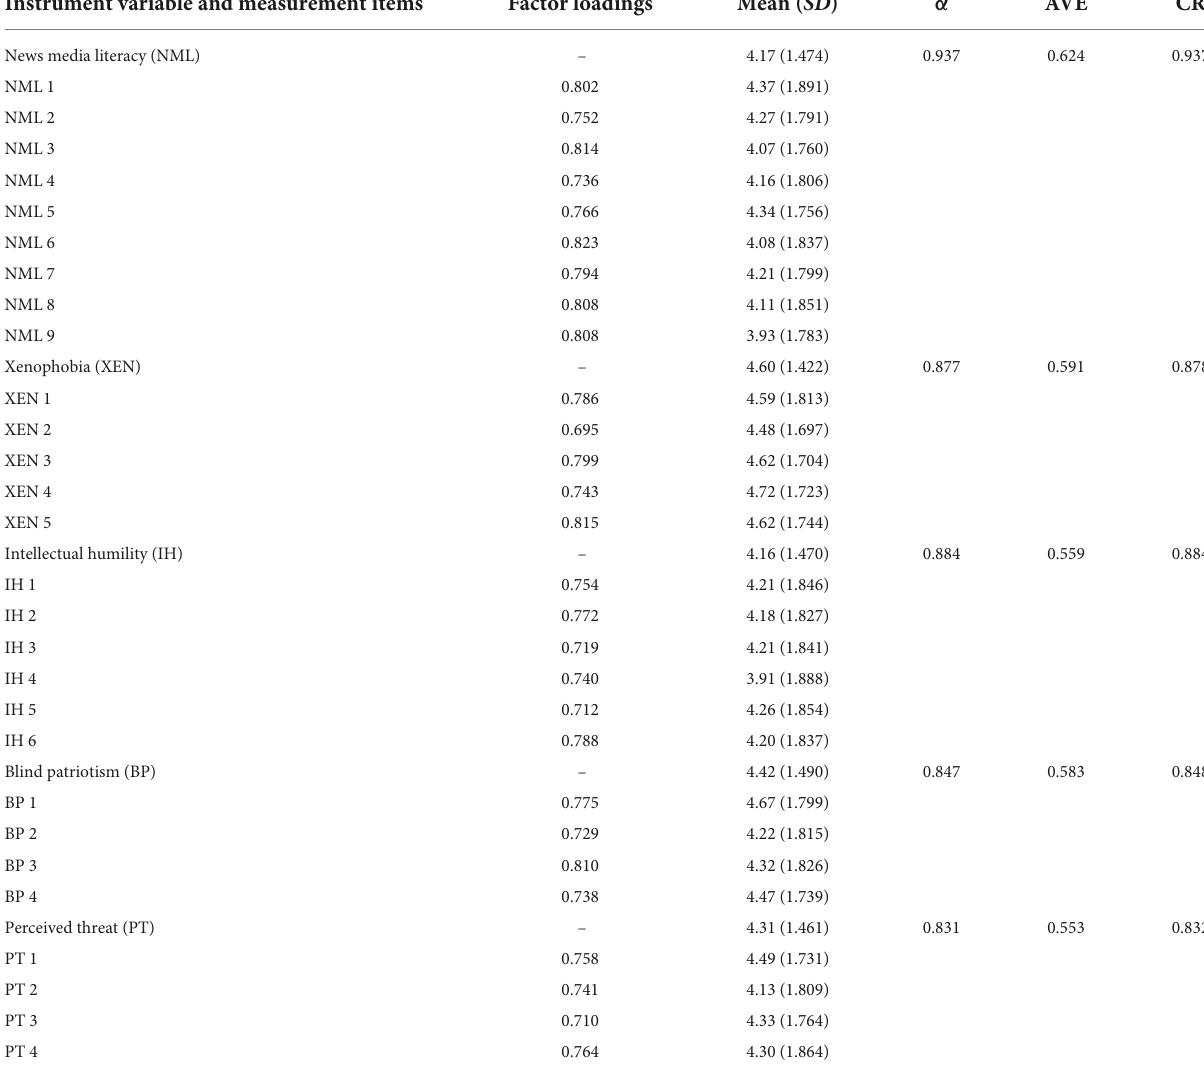
TABLE 3 The item factor loadings, CR, Cronbach’s alpha values, and the instrument variable descriptive statistics ( N = 430). Instrument variable and measurement